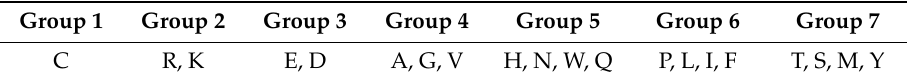
Table 2. Seven groups of amino